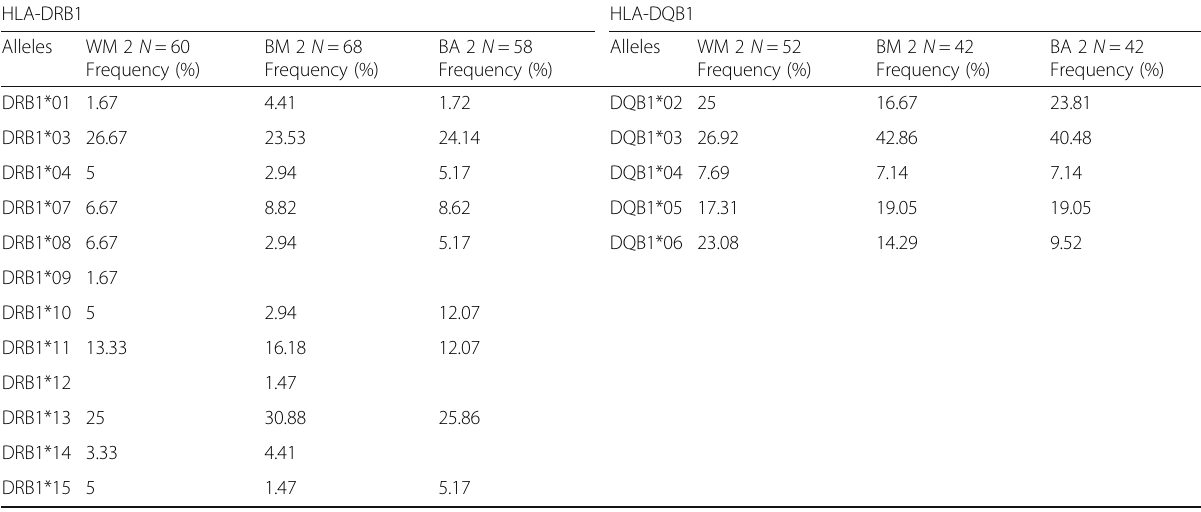
Table 3 Ethnic distribution of Class II HLA HLA-DRB1 HLA-DQB1